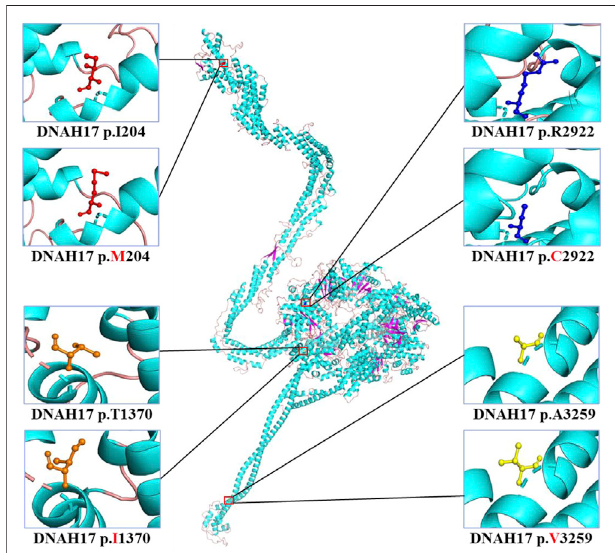
FIGURE 3 | Cartoon model of the dynein axonemal heavy chain 17 protein structure visualized by PyMOL based on the SWISS-MODEL. The isoleucine (I) and mutated methionine (M) at position 204; threonine (T) and mutatedisoleucine(I)atposition1370;arginine(R)andmutatedcysteine (C)atposition2922;andalanine(A)andmutatedvaline(V)atposition3259are indicated with ball-and-stick